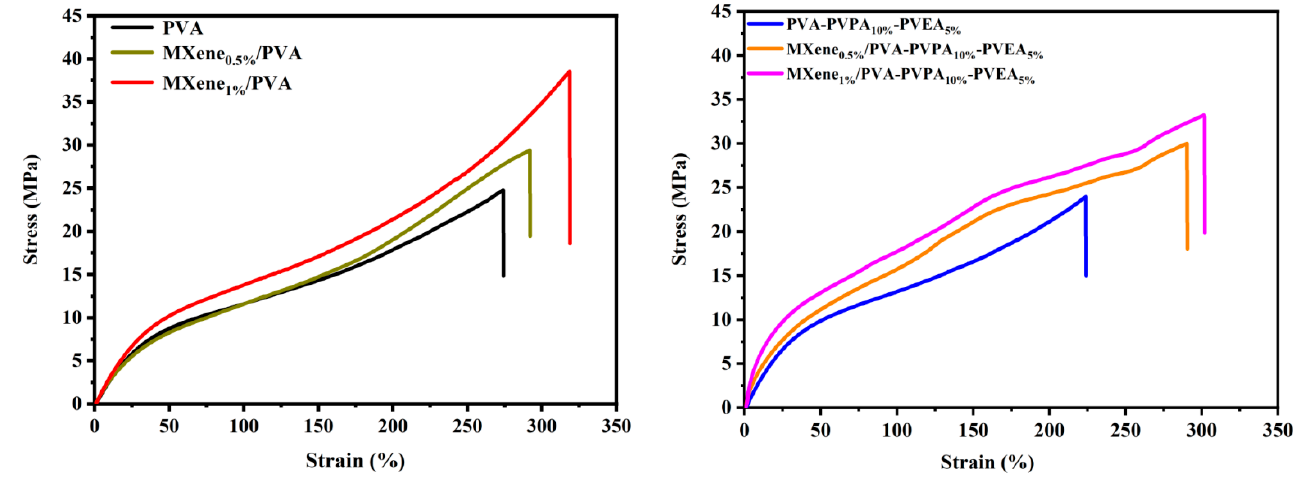
Figure 12. Stress–strain curves of PVA and MXene/PVA nanocomposites. Table 6. The tensile strength and elongation at break of PVA and MXene/PVA nanocomposites. Samples